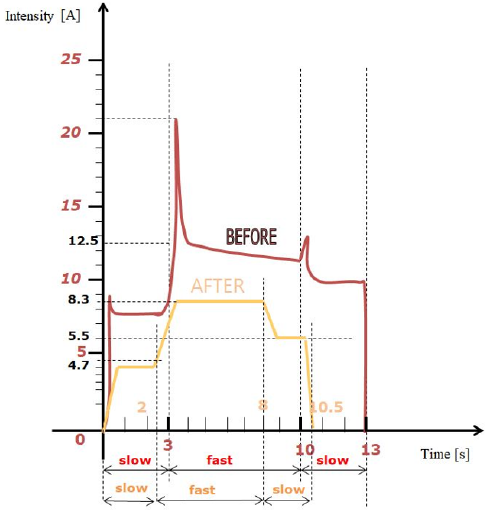
Figure 10. Engine intensity measured over time after improvement.